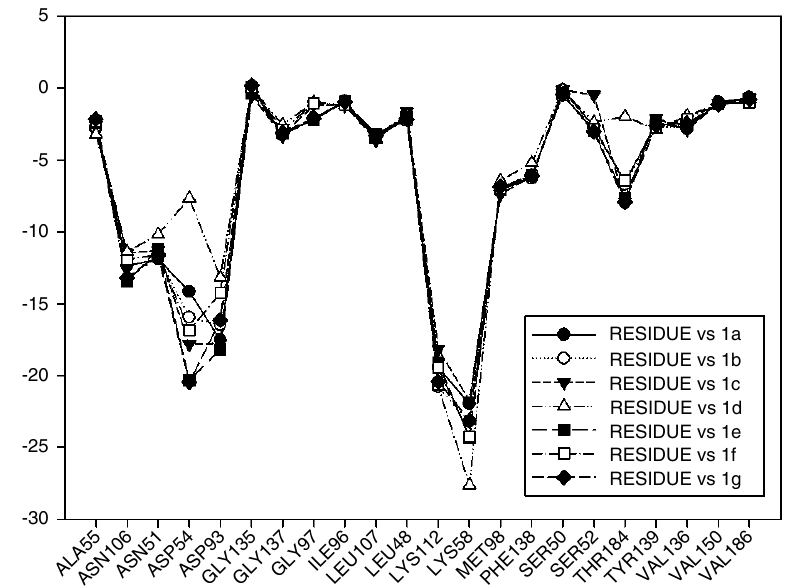
Figure 10. Interaction energies of 11-hydroxy analogues and